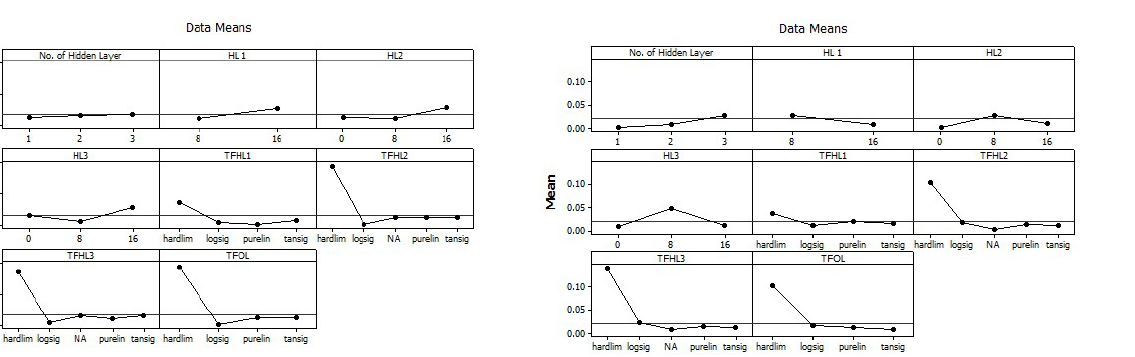
Fig. 7. (a). Tenure vs. Con- formance